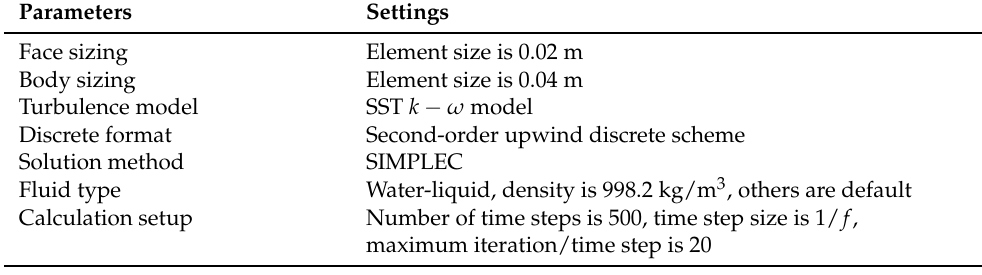
Table 7. Parameter settings of CFD method for unsteady motion simulation.